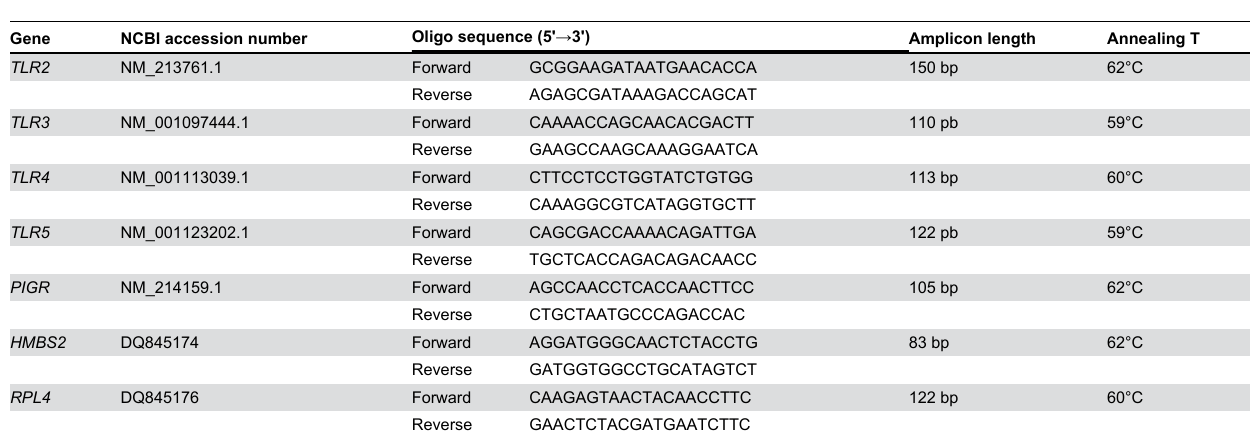
Table 1. Primers information and RT-qPCR conditions used in the trial.